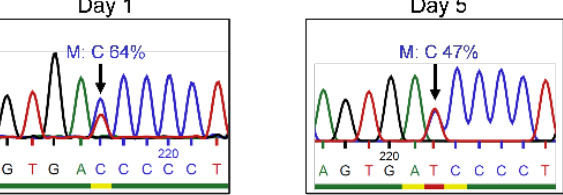
Figure 1. Frequency of the IL2RG c.458T>C mutation in mosaic T cells. Expanded CD3 + T cells of P1 were harvested to purify gDNA on days 1 and 5 post-isolation, separately. Sanger sequencing showed the frequency of the mutant (M) base, C, was 64% on day 1 and 47% on day 5 in the mosaic T cells (the blue, red, green, and black peaks stand in place of bases C, T, A, and G respectively).